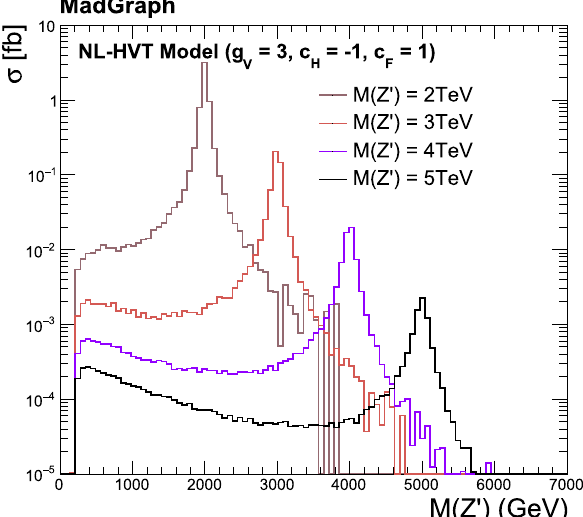
Fig. 5 Z (cid:2) → Z H → (cid:10)(cid:10)γγ Higgs yields with respect to diphoton γγ transverse momentum dN / dP , in fb, as predicted from the non- T local form factor in Eq. 3 with a = 1. The expected SM Higgs yield for the same selection is overlayed in yellow